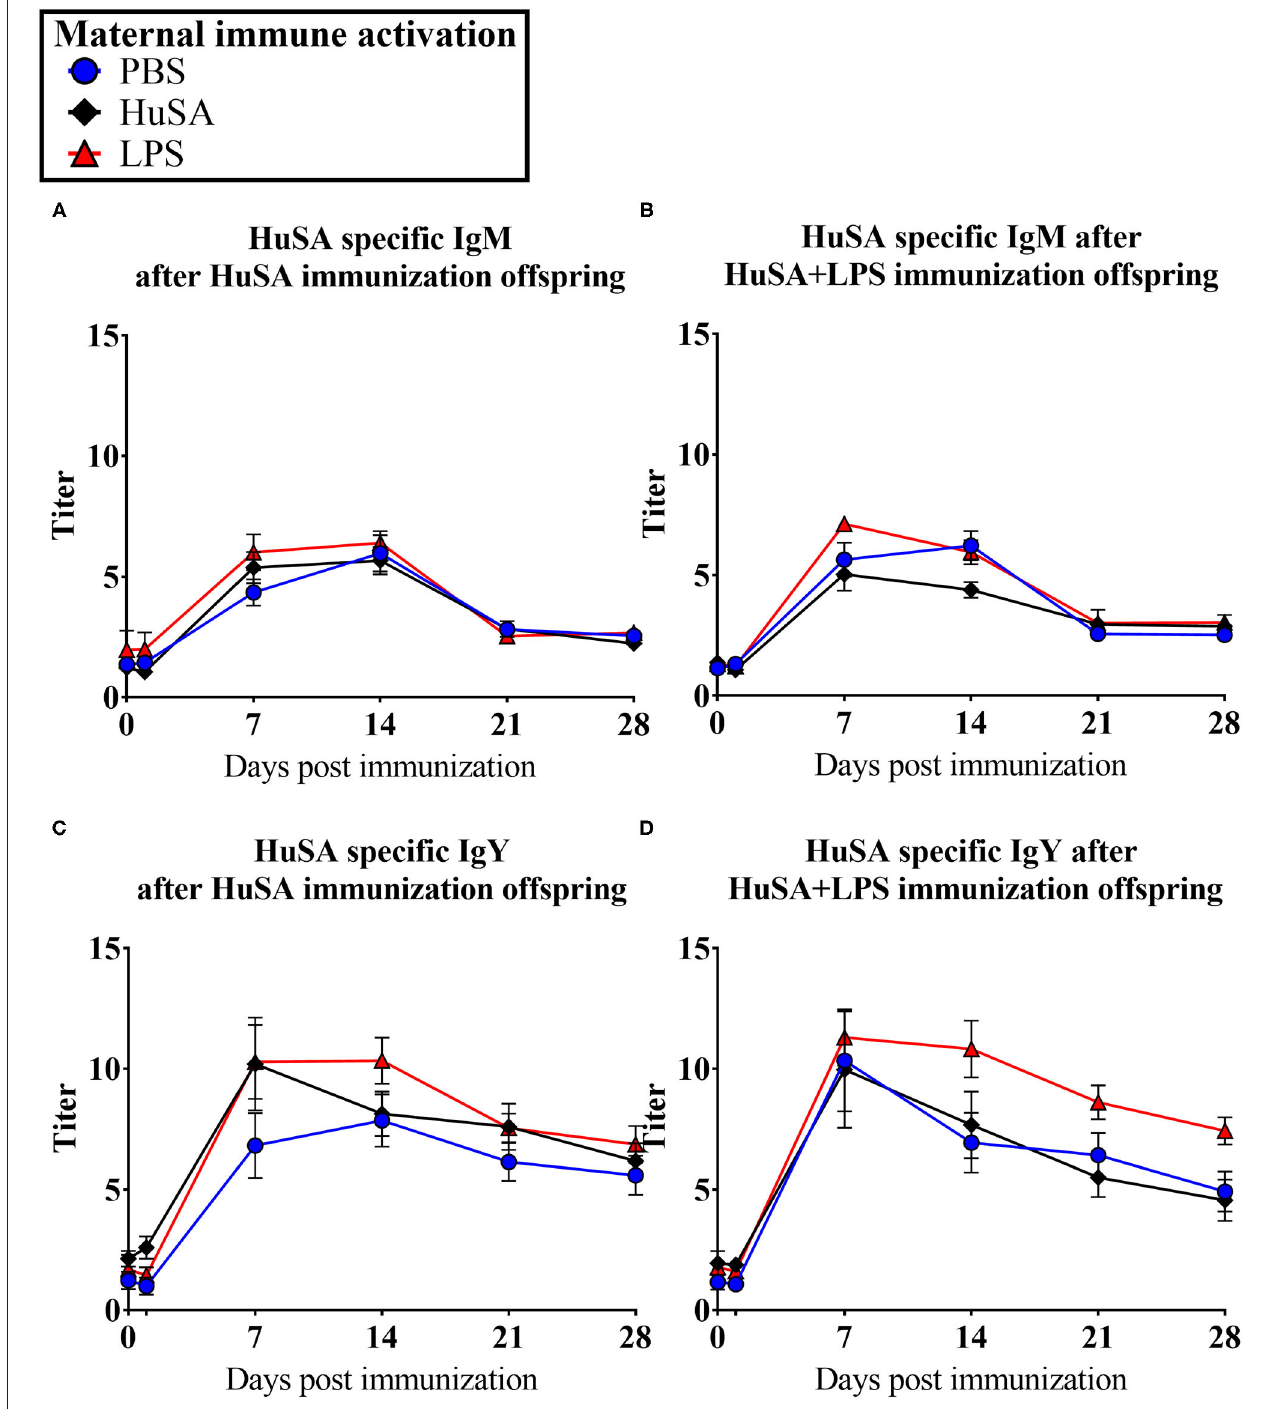
FIGURE 2 | Results of experiment 1 with IgM and IgY anti-HuSA titers of chicks originating from immune activated hens with either PBS, HuSA or LPS. The chicks were immunized 4 weeks post hatch with either HuSA or HuSA + LPS. Titers were measured at 0, 1, 7, 14, 21 and 28 days post immunization. (A) anti-HuSA IgM titers after HuSA immunization. (B) anti-HuSA IgM titers after HuSA + LPS immunization (C) anti-HuSA IgY titers after HuSA immunization. (D) anti-HuSA IgY titers after HuSA + LPS immunization. Data are presented as means ± SEM, and N = 20 chickens per group.